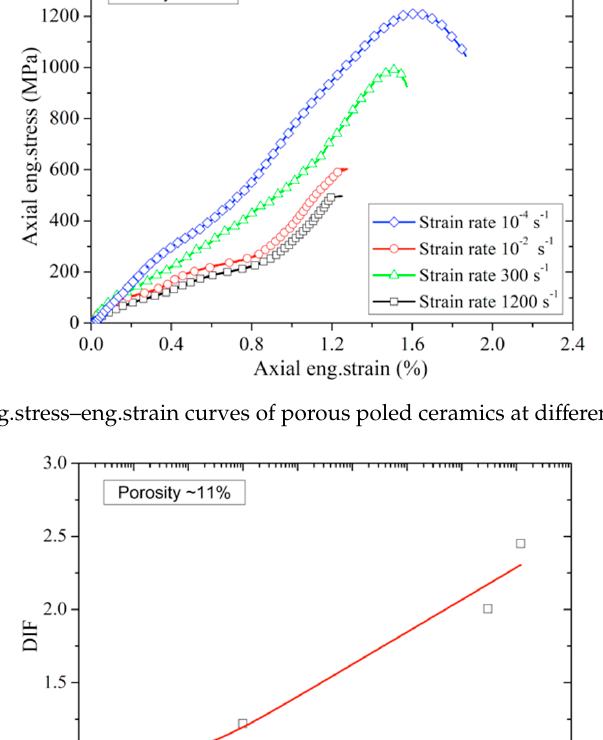
Figure 15. The dynamic increase factor as a function of strain rate.